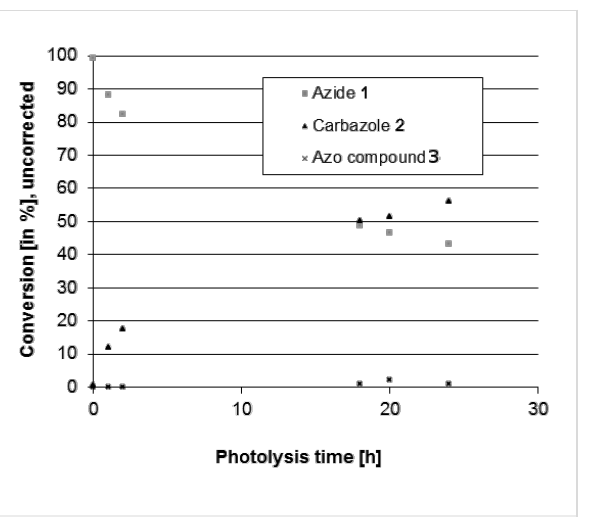
Figure 4: Carbazole synthesis in miniaturized photoreactors Type II (PEEK and Teflon), power control, flow 26